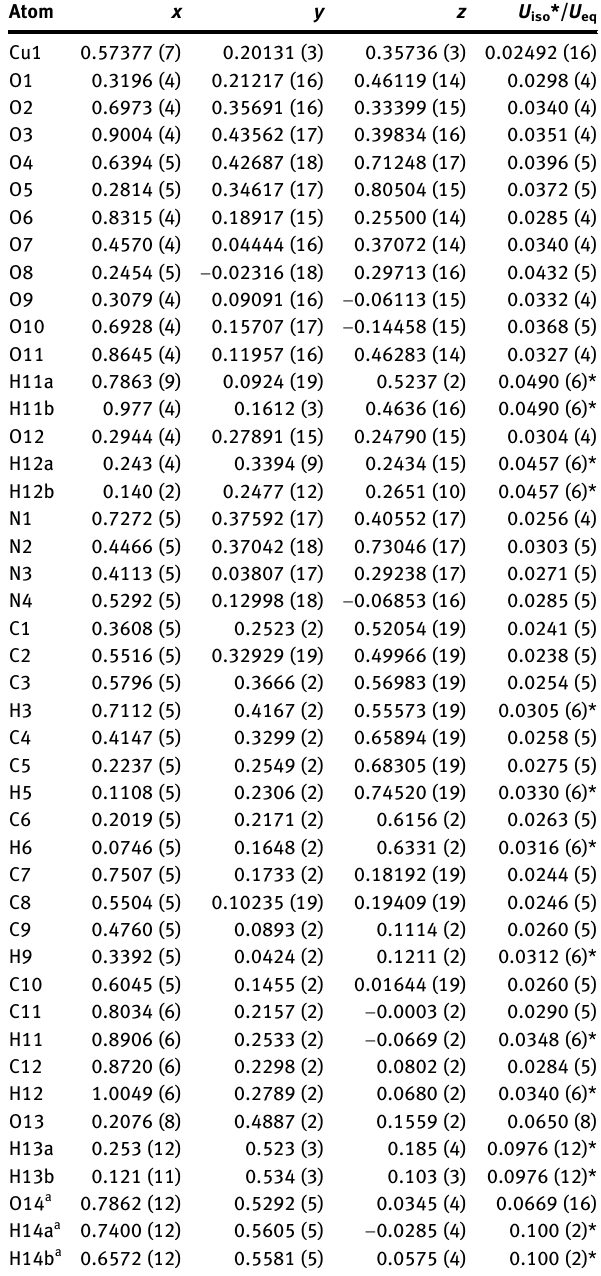
Table  : Fractional atomic coordinates and isotropic or equivalent isotropic displacement parameters (Å 